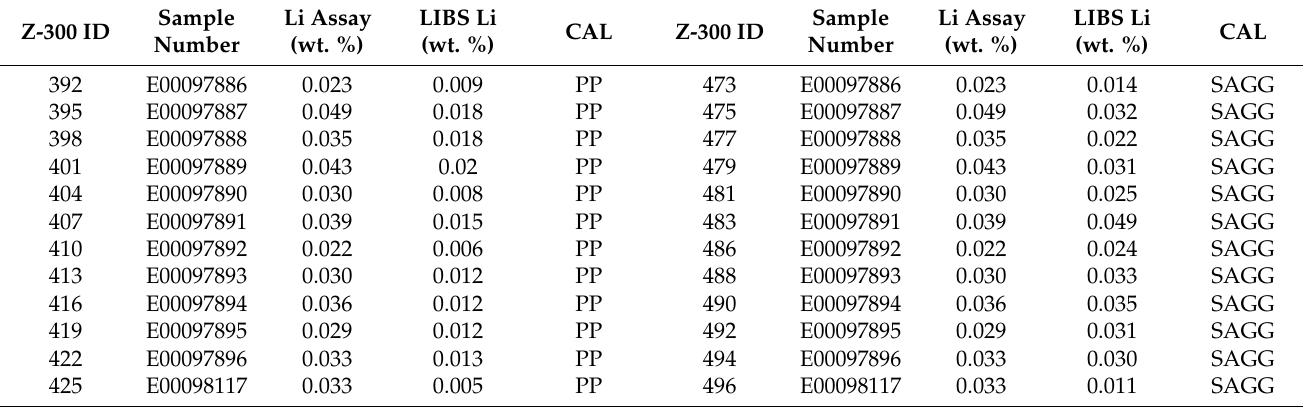
Table 3. Comparison of Li analysis for a soil core on the Carolina Lithium Project prospect using